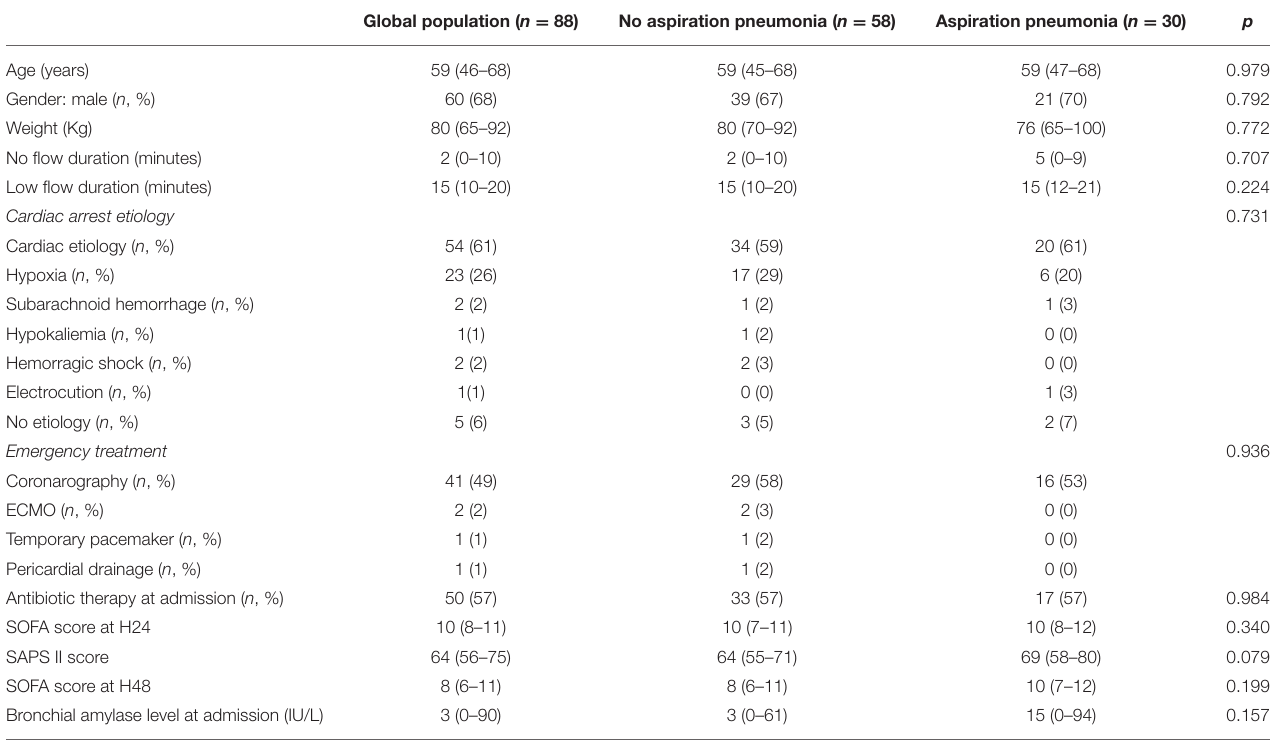
TABLE 1 | Clinical characteristics of patients at Intensive Care Unit (ICU)